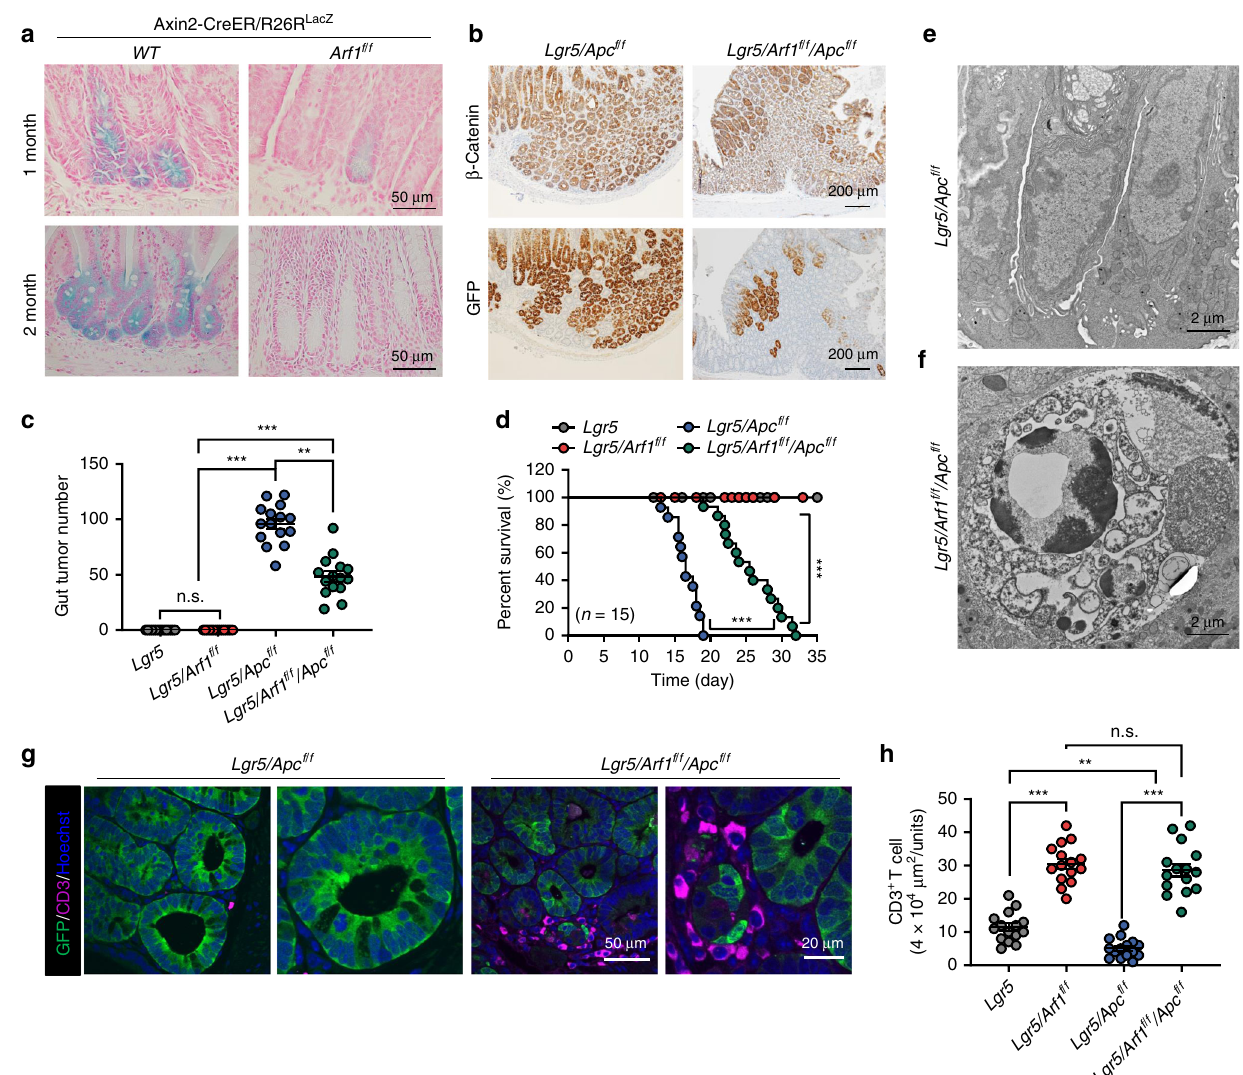
Fig. 1 Arf1 knockdown reduces the CSC and extends the lifespan of Lgr5/Apc mice. a LacZ-stained sections of intestine from an Axin2-CreER/Rosa26R or an Axin2-CreER/Rosa26R/Arf1 f/f mouse that was treated with fi ve intraperitoneal injections of tamoxifen to activate stem-cell-speci fi c Cre and facilitate the loss of Arf1. b Lgr5/Apc or Lgr5/Apc/Arf1 mice were treated with three continued intraperitoneal injection of tamoxifen to activate the stem-cell- speci fi c Cre and facilitate the loss of Apc and Arf1. β -Catenin and GFP mark stem cells. c Intestinal tumor number in the indicated genotypes ( n = 15 mice per group; *** p < 0.001, t -test; repeated three independent times). d Percent survival curves of mice with the indicated genotypes ( n = 15 mice per group; *** p < 0.001, t -test; repeated three independent times). e , f Electron microscopy sections of mouse intestinal crypts with the indicated genotypes. g Immuno fl uorescent staining of CD3, GFP, and Hoechst in intestinal sections of mice with the indicated genotypes. h Quanti fi cation of in fi ltrated CD3 + T cells in mice with the indicated genotypes ( n = 15 mice per group; n.s. is not signi fi cant, ** p < 0.01, *** p < 0.001, t -test; repeated three independent times). Each experiment replicate three times. Data are shown as the mean ± SEM. Scale bars are as